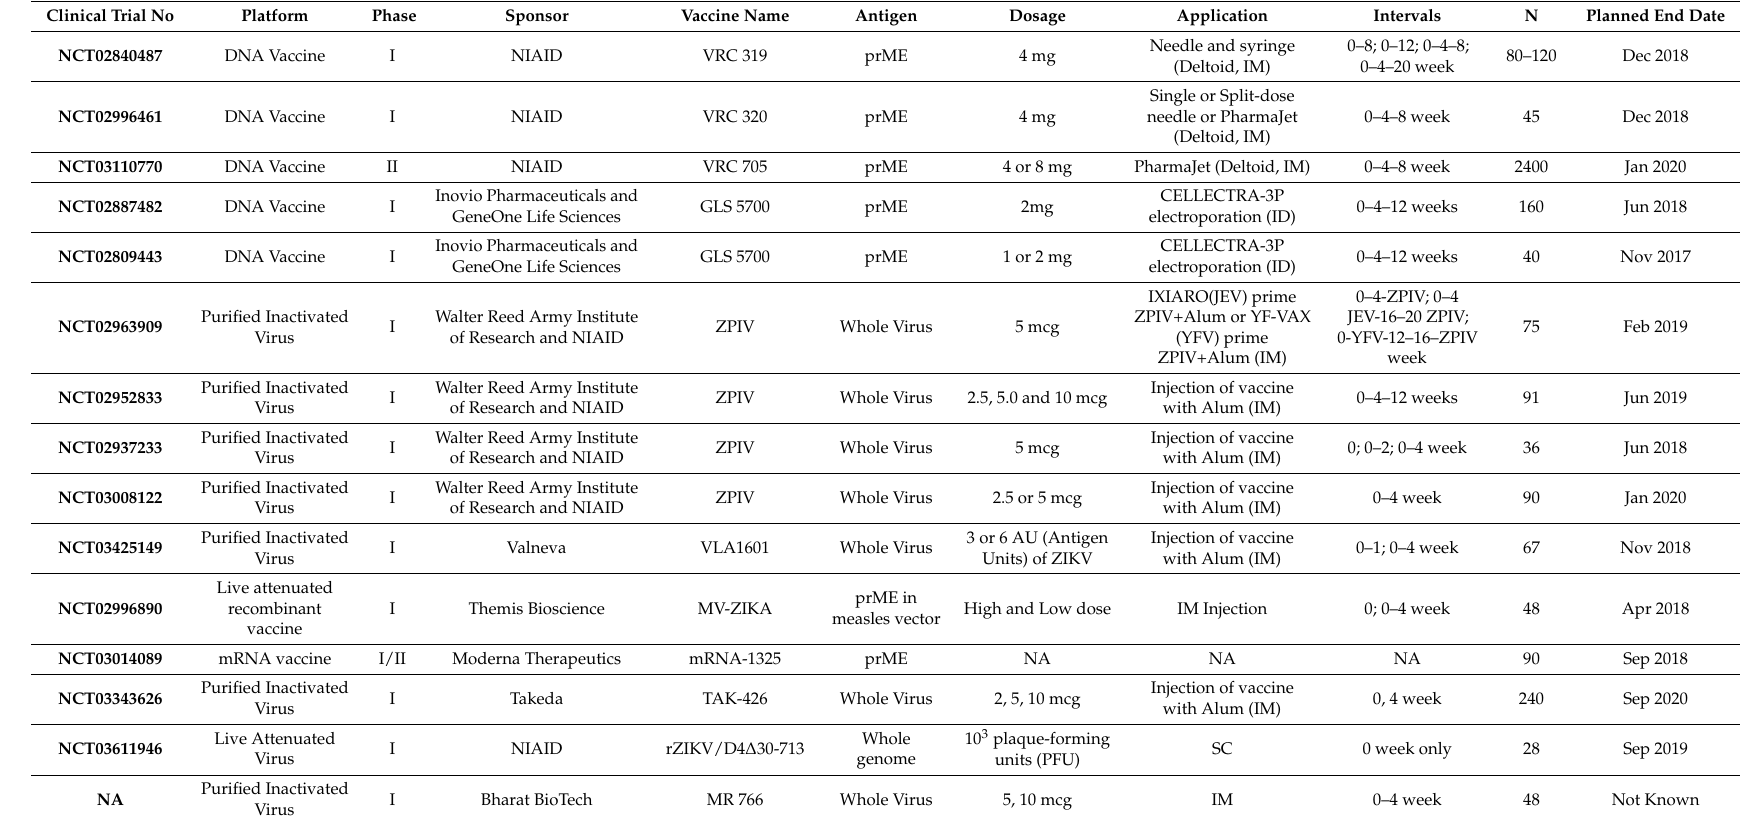
Table 1. Zika vaccine platforms in clinical